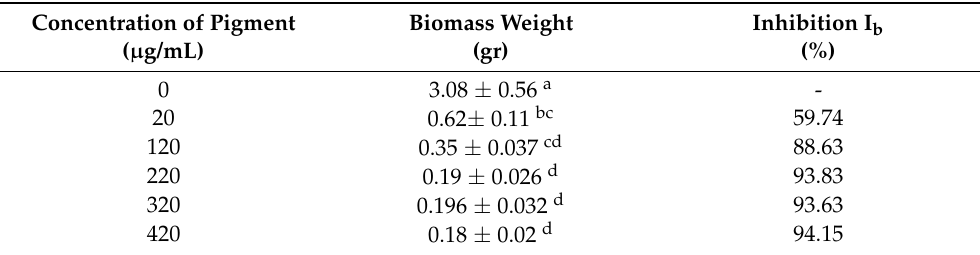
Table 3. Efficacy of prodigiosin produced by Serratia rubidaea Mar61-01 on mycelial biomass of Botrytis cinerea .